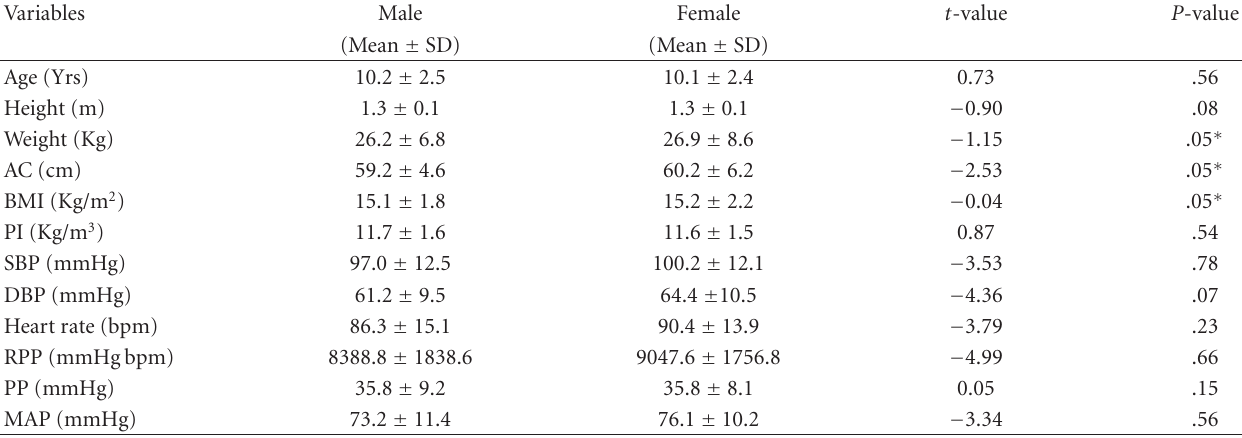
Table 3: Comparison of male and female physical characteristics and cardiovascular parameters.